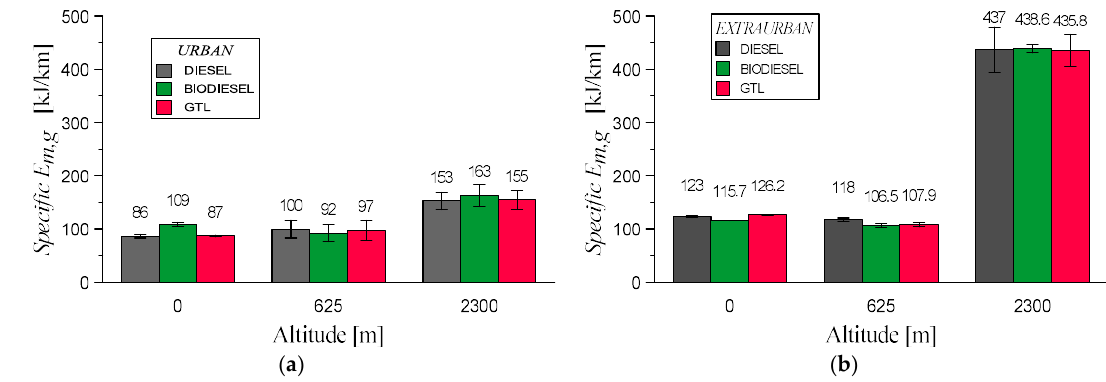
Figure 7. Specific exergy of exhaust gases: ( a ) Urban driving conditions, ( b ) Extra-urban driving